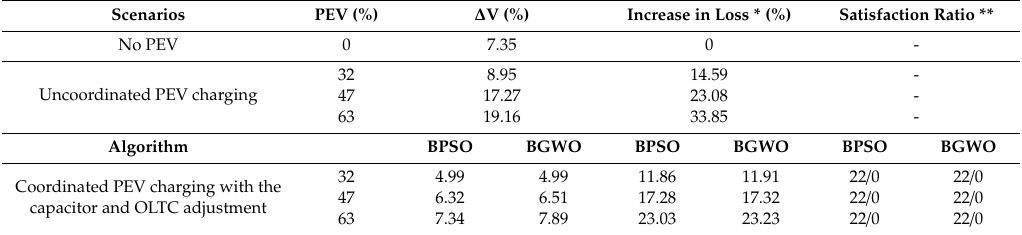
Table 2. Technical impact of PEV charging in di ff erent scenarios on the distribution system.